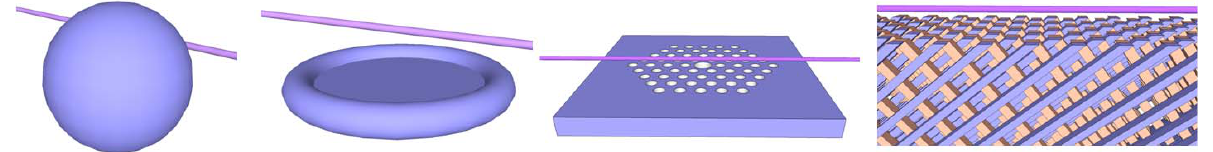
Figure 2. Representative microcavity geometries: Micro-sphere, micro-toroid, 2D photonic crystal slab, and 3D photonic crystal (woodpile) are shown from left to right. A tapered fiber proximate to each microcavity enables the evanescent field coupling to a microcavity mode. An integrated optical waveguide coupled to a microcavity is an alternative to the tapered fiber.